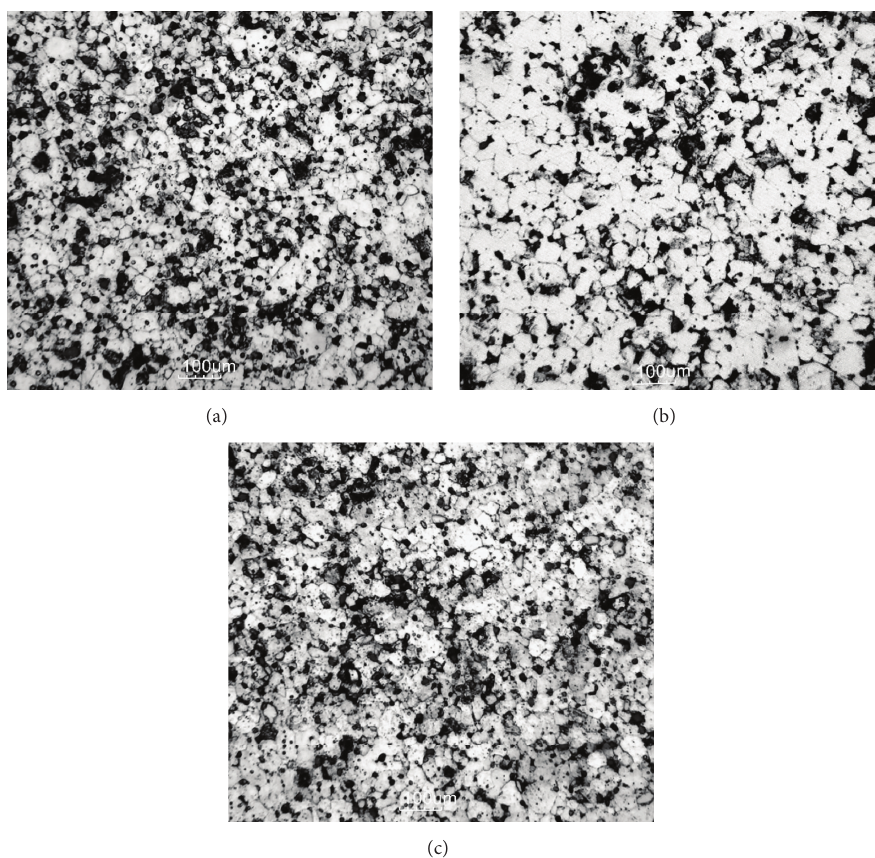
Figure 16: Optical micrographs of NdPr magnets: (a) 30Nd6Pr, (b) 30Nd8Pr, and (c) 30Nd10Pr.